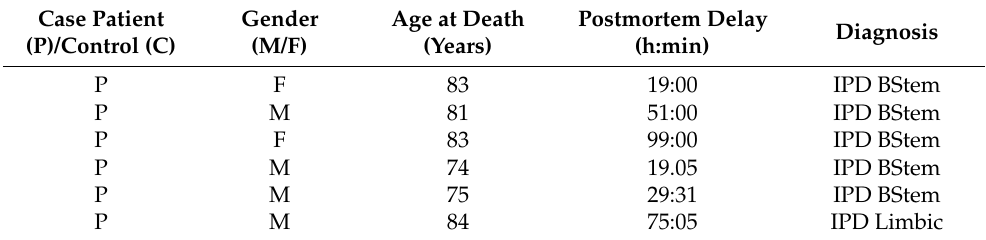
Table 1. Selected demographics of cases